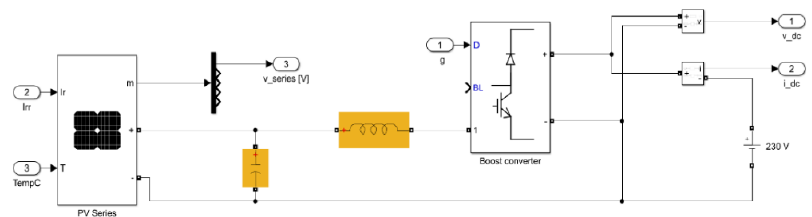
Figure 7. PV electrical subsystem diagram.